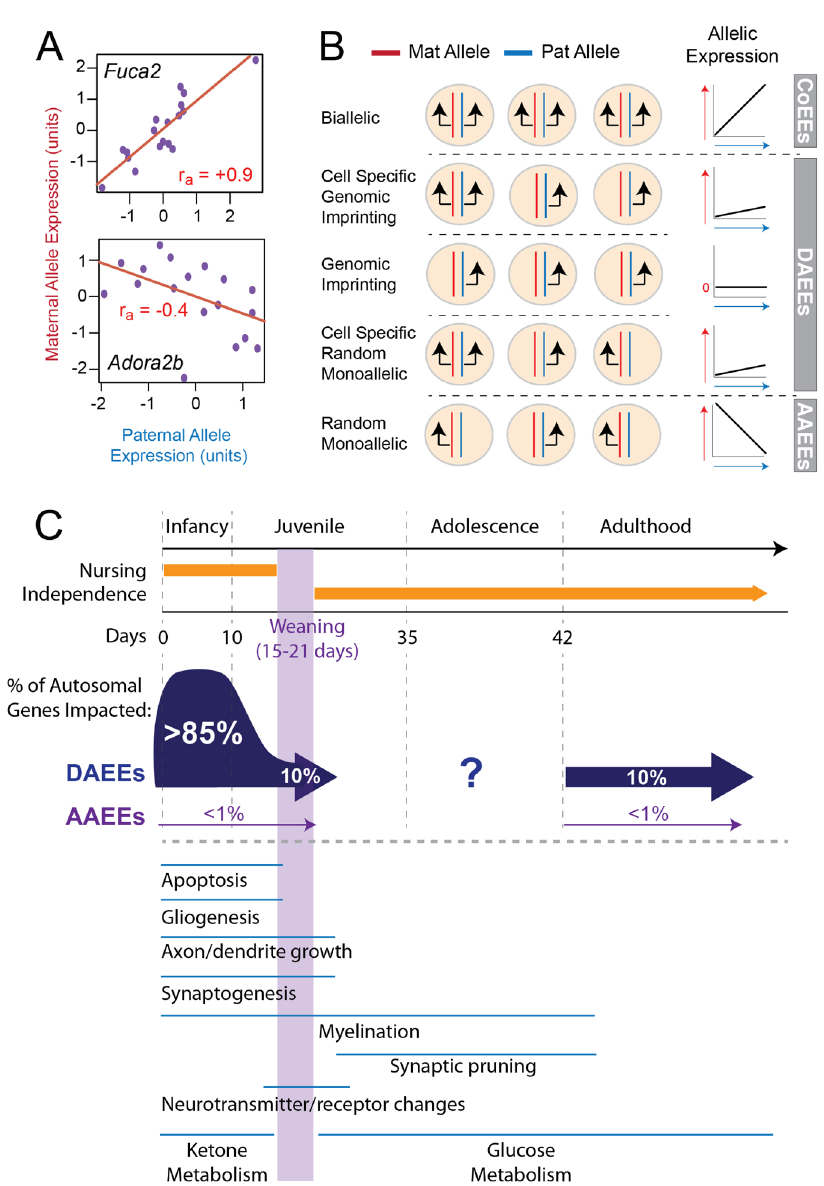
Figure 3. RNA-Seq approach to screen for high-confidence, non-genetic differential allele expression effects in vivo . ( A ) The approach involves RNA-Seq profiling of maternal and paternal allele expression levels across a population of individuals and examining the correlated expression of the two alleles across the population. For example, Fuca2 exhibits highly correlated allelic expression, while the maternal and paternal alleles for Adora2b are negatively correlated. Statistical modeling is performed to estimate the effects of technical noise, biological variation, and genetic variation on the data. The resulting statistic identifies high-confidence, non-genetic allelic effects in a genome-wide manner for any tissue. ( B ) This in vivo screening approach can detect diverse forms of allelic effects. Biallelic expression at the cellular level is expected to manifest as highly correlated allelic expression. Clonal random monoallelic expression (RME) that is similar to X-inactivation will manifest as a negative allele correlation (antagonistic allele expression effects, or AAEEs), since more maternal allele-expressing cells arise at the expense of paternal allele-expressing cells and vice versa. Genome imprinting and cell-specific imprinting or RME will manifest as a weak correlation or no correlation between the alleles; we refer to these cases more generally as differential allele expression effects (DAEEs). ( C ) Profiling of non-genetic allelic effects in the postnatal day 5 (P5) and P15 and adult mouse DRN revealed major developmental differences. Most genes exhibit evidence for high-confidence DAEEs in the P5 DRN, but these effects are reduced by P15 and in adults such that only 10% of autosomal genes exhibit DAEEs at these older ages. AAEEs are rare in vivo and impact less than 1% of all autosomal genes expressed. The in vivo developmental shift in non-genetic allelic effects is presented relative to other major developmental milestones and processes in the mouse brain. We applied a similar approach to study DAEEs in the primate brain. CoEE, co-expression